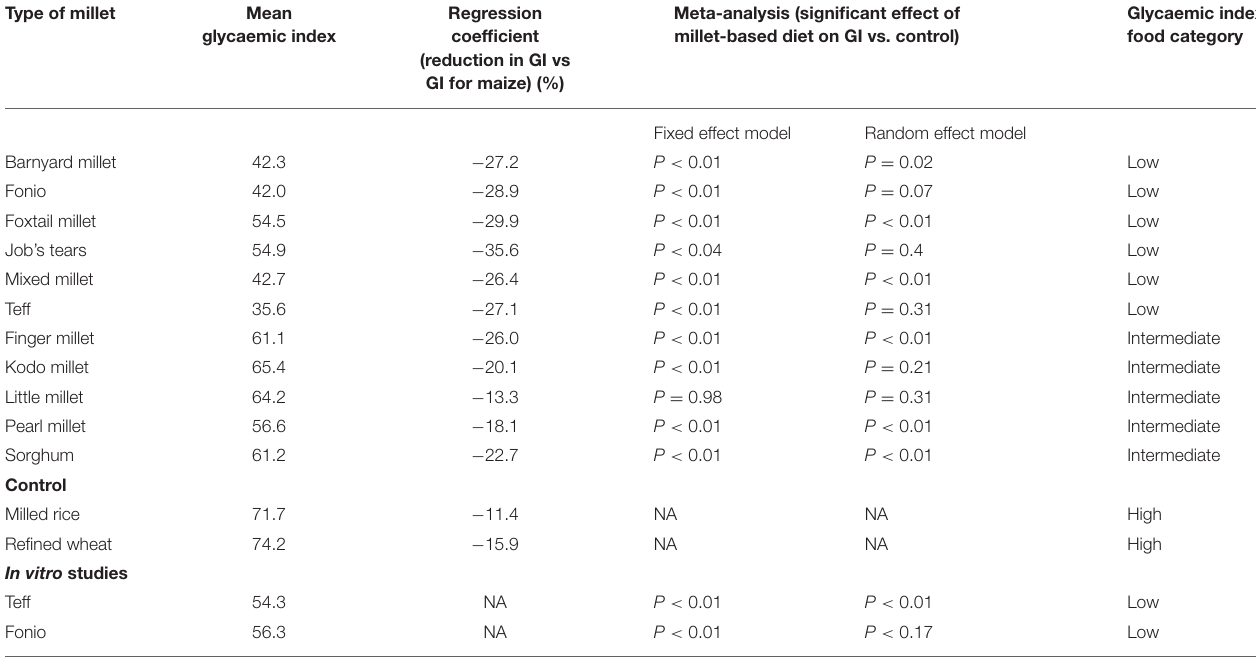
TABLE 2 | A comparison of millets’ glycaemic index measured in vivo with control samples using different statistical analyses. Type of millet Mean glycaemic index